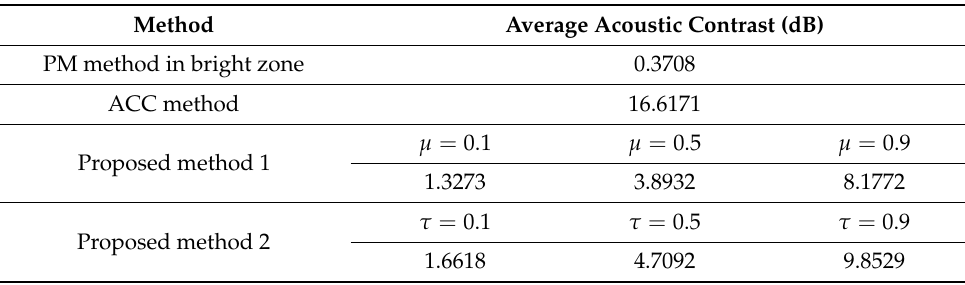
Table 3. Average acoustic contrast of different methods relative to frequency for two-dimensional experiment.